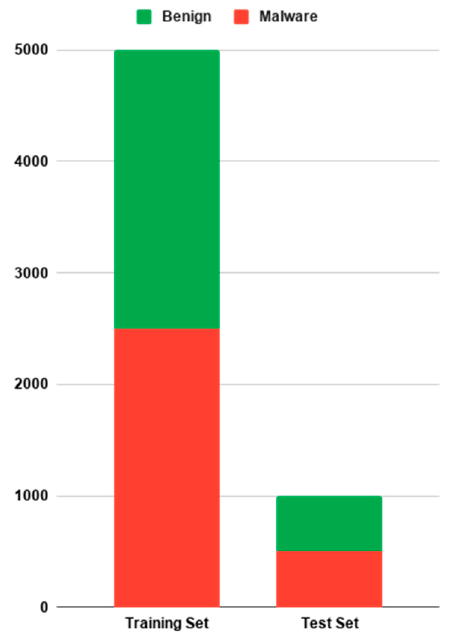
Figure 5. Sample distribution in our training and test subsets.